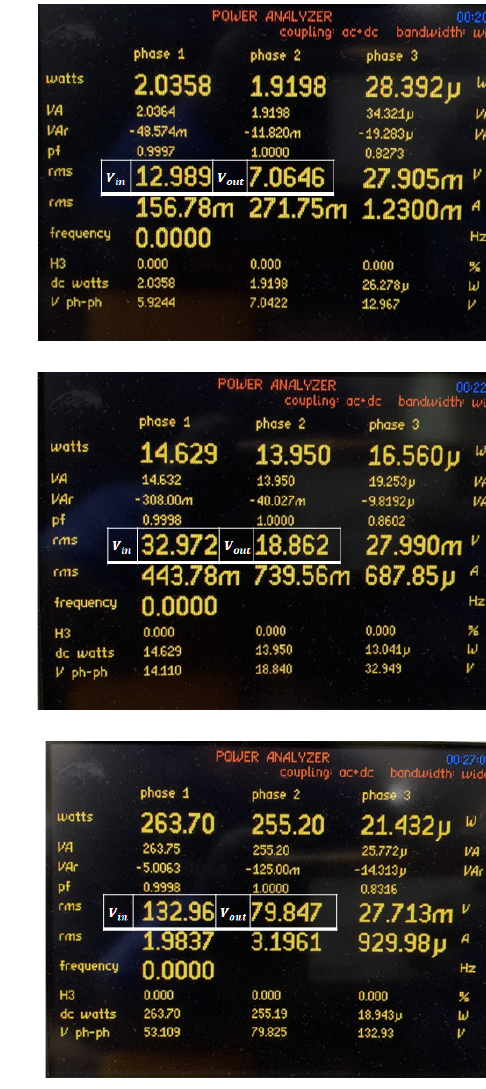
Figure 9. DAB converter experimental setup.